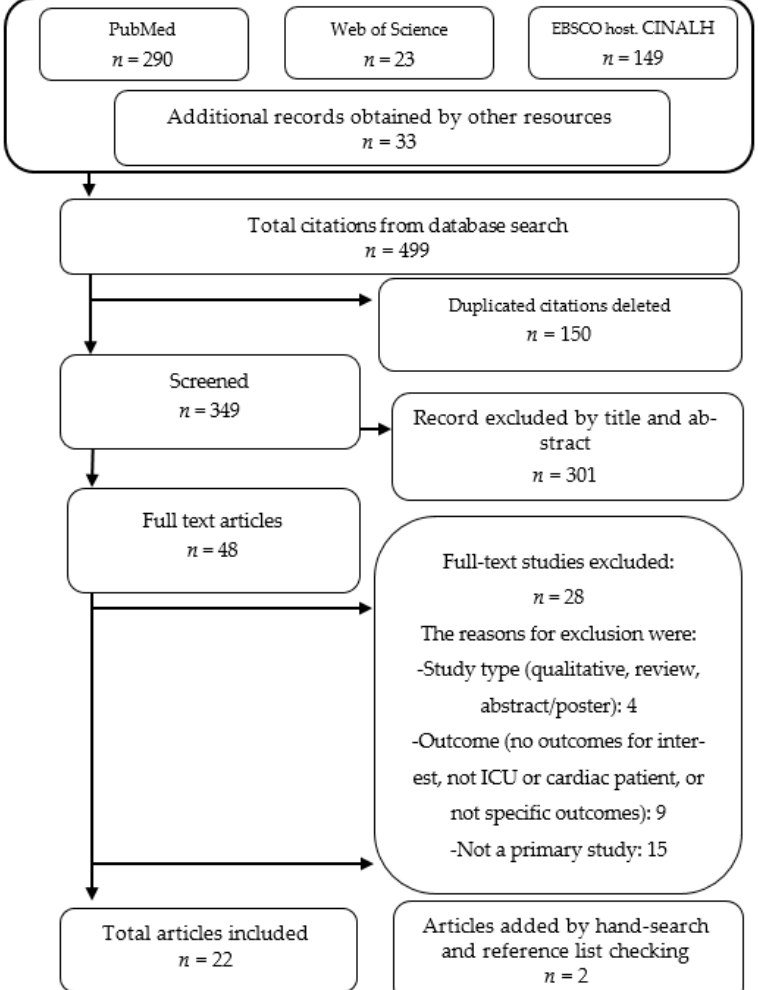
Figure 1. Search and selection flow diagram. ICU, intensive care unit.